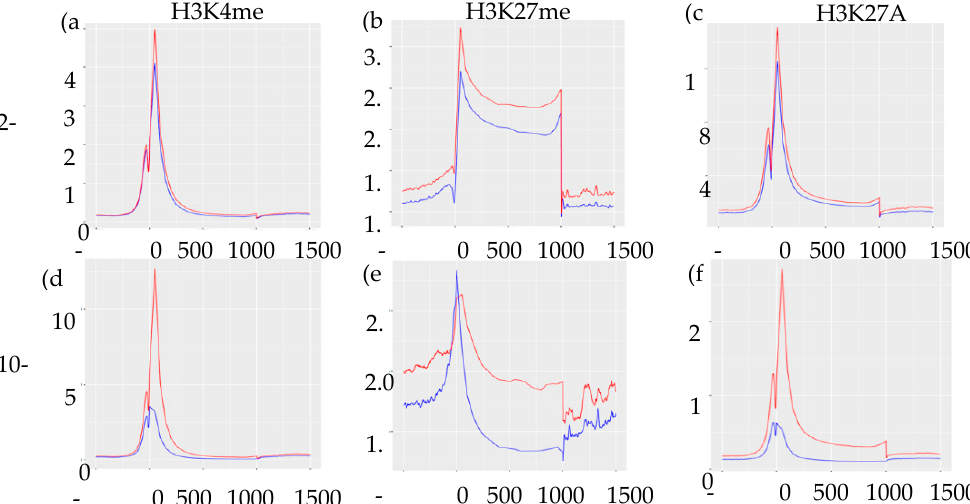
Figure 3. Transcription start site plots (TSS plots) of histone modifications showing the distribution and enrichment of each histone mark. ( a – c ) represents H3K4me3, H3K27me3, and H3K27Ac marks in 2-wk islets, respectively. ( d – f ) represents H3K4me3, H3K27me3, and H3K27Ac mark in 10-wk islets, respectively. Peak input / enrichment shown on vertical axes and position base-pair shown on horizontal axes. Red lines indicate control islets and blue lines indicate IUGR islets.